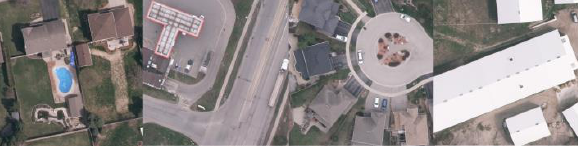
Figure 4 . The imagery